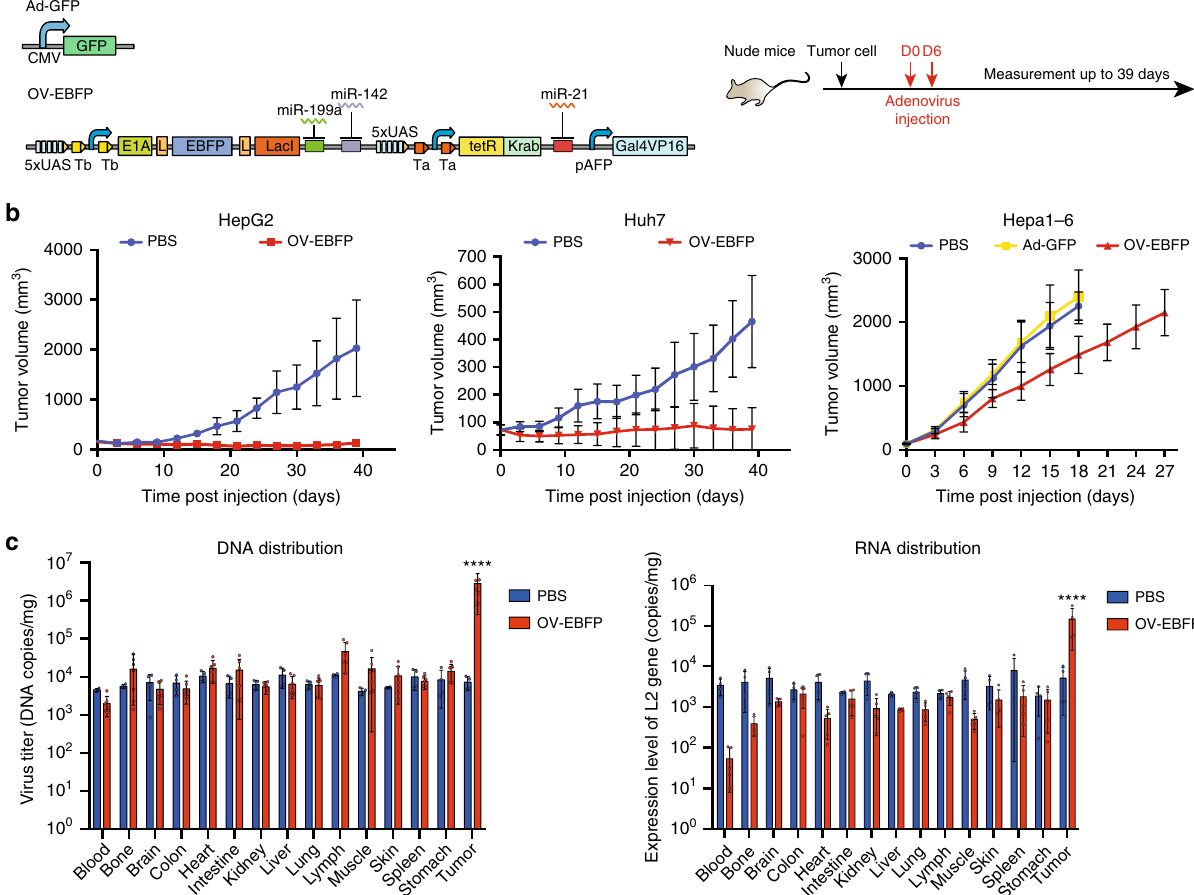
Fig. 5 Effect of synthetic oncolytic adenovirus in nude mouse models. a The schematic diagram of OV-EBFP and non-replicable adenovirus (Ad-GFP). The experimental design of nude mouse experiments is shown in the right panel. b 1 × 10 9 VP of OV-EBFP or Ad-GFP were injected into indicated xenografted tumor twice a week right after the size of tumor reached ~100 mm 3 . PBS was used as a negative control. Each data point shows the mean ± s.d. tumor size ( n = 9 or 10) at indicated day. c DNA (left) and RNA (right) distribution of OV-EBFP in HepG2 xenografted nude mice 1 week after injection of 1 × 10 9 VP of OV-EBFP ( n = 7 in left, n = 5 in right) when the size of tumor exceeded ~500 mm 3 . PBS ( n = 4) was used as a negative control. Data are shown as mean ± s.d. from three independent replicates by using quantitative PCR. Student ’ s t-test was performed. Data are shown as mean ± s.d., * P < 0.05, ** P < 0.01, *** P < 0.001, **** P < 0.0001. Source data are provided as a Source Data fi